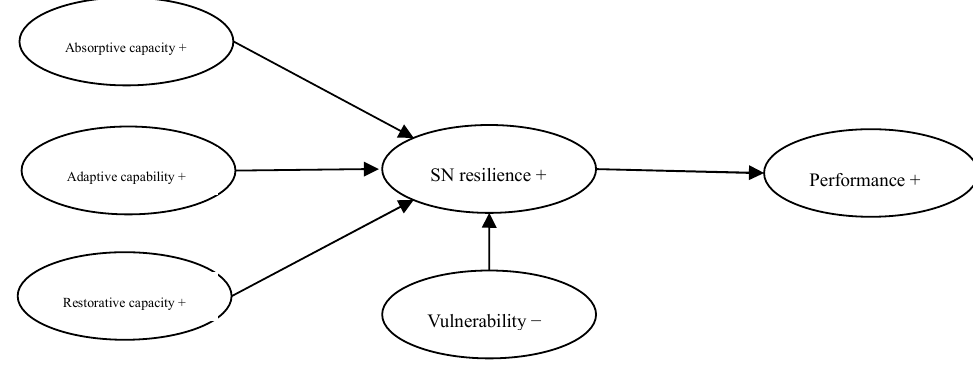
Figure 2. Supply chain design strategies for supply network (SN) resilience.